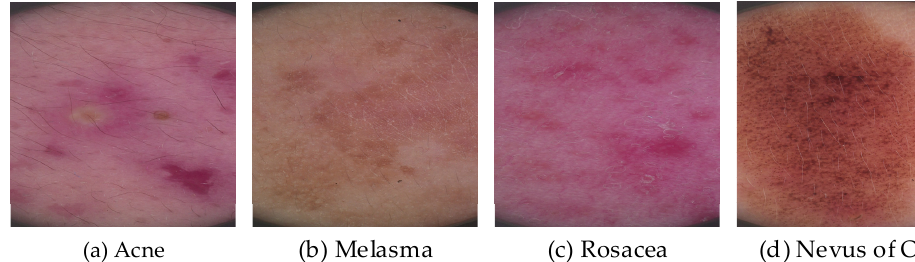
Figure 4. Sample images of the four skin diseases.